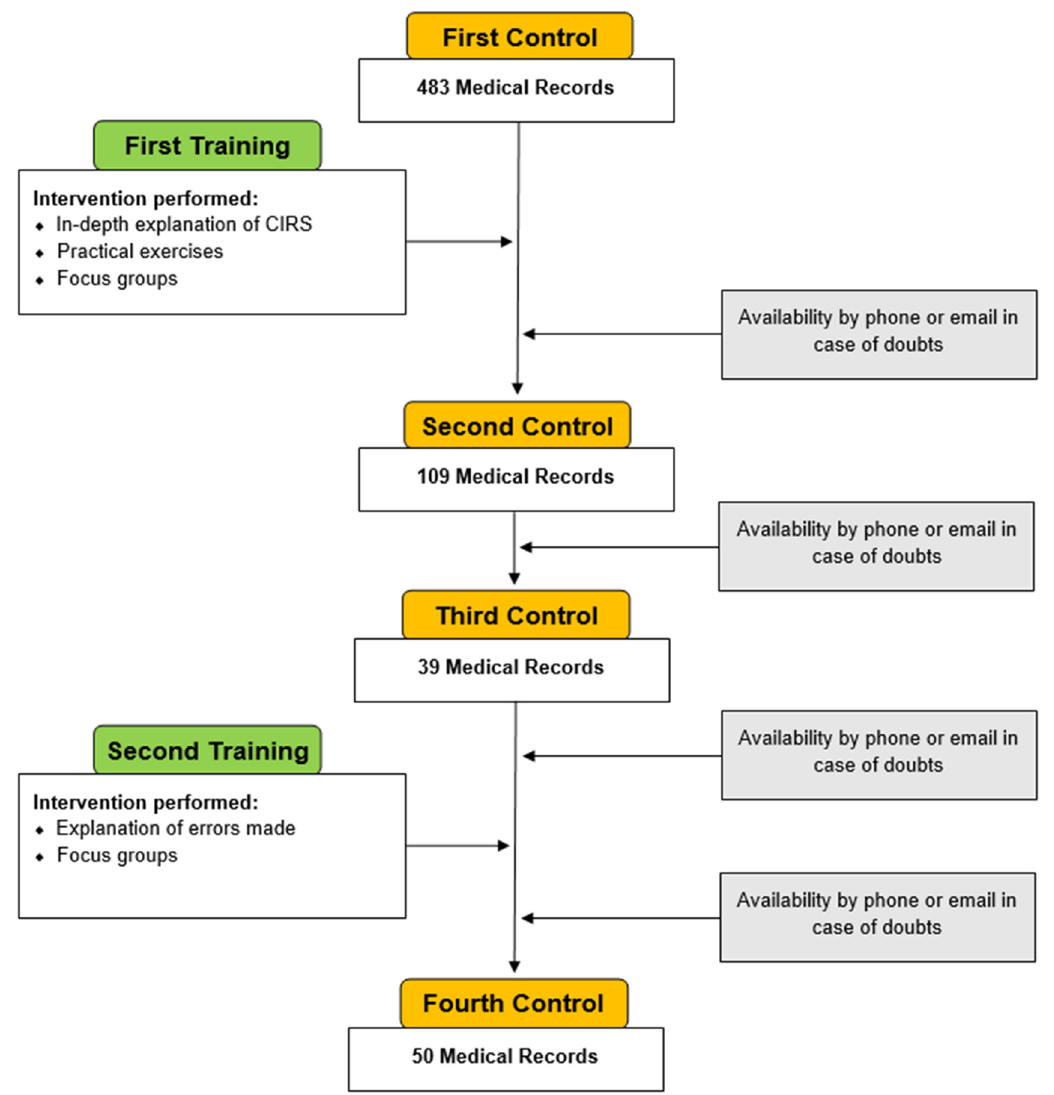
Figure 1. Flow chart of our project.